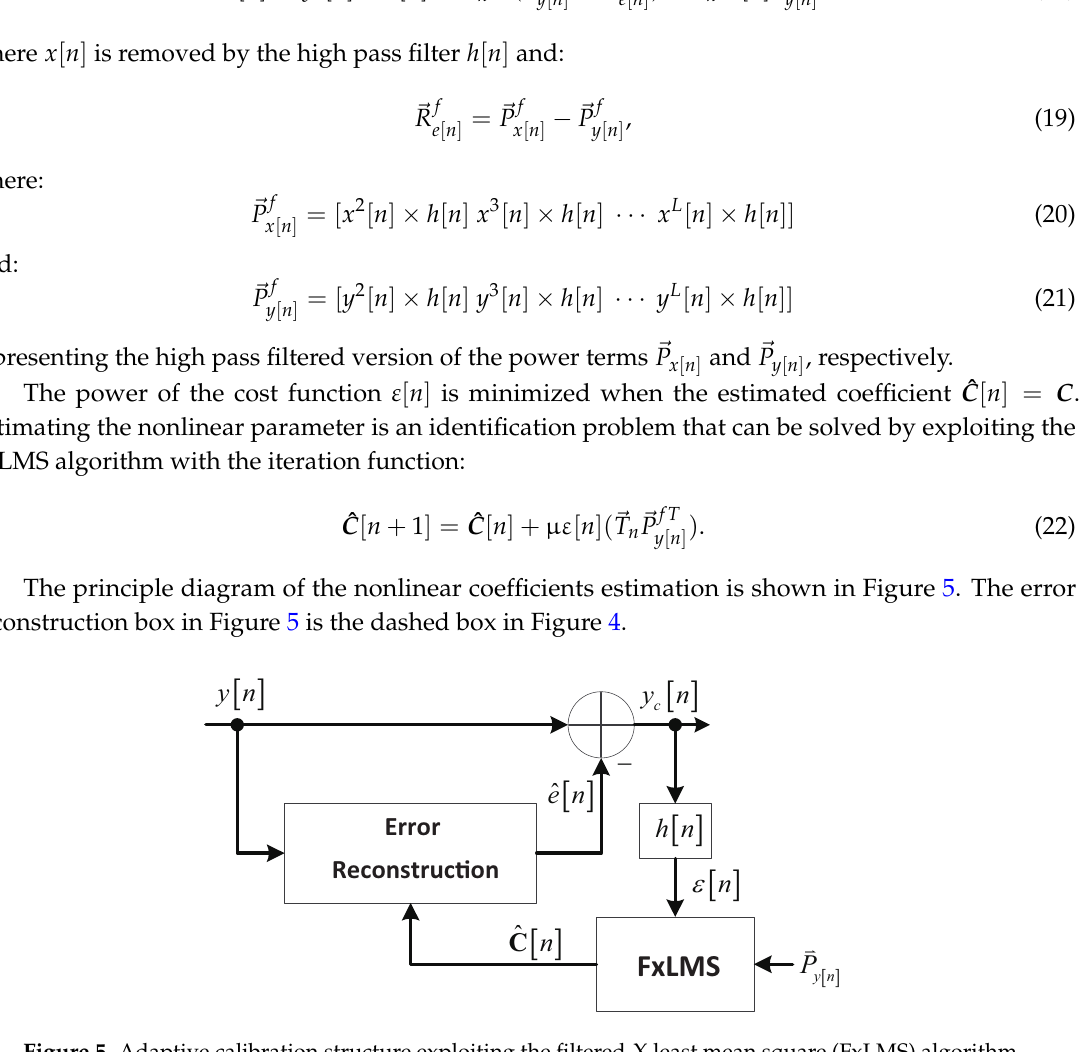
Figure 5. Adaptive calibration structure exploiting the filtered-X least mean square (FxLMS)